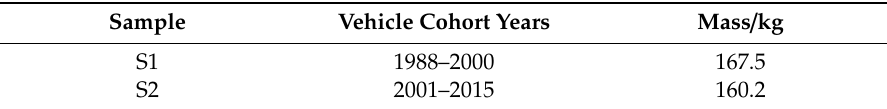
Table 1. Description of primary shredder light fraction (SLF) samples taken after shredding end-of-life vehicles